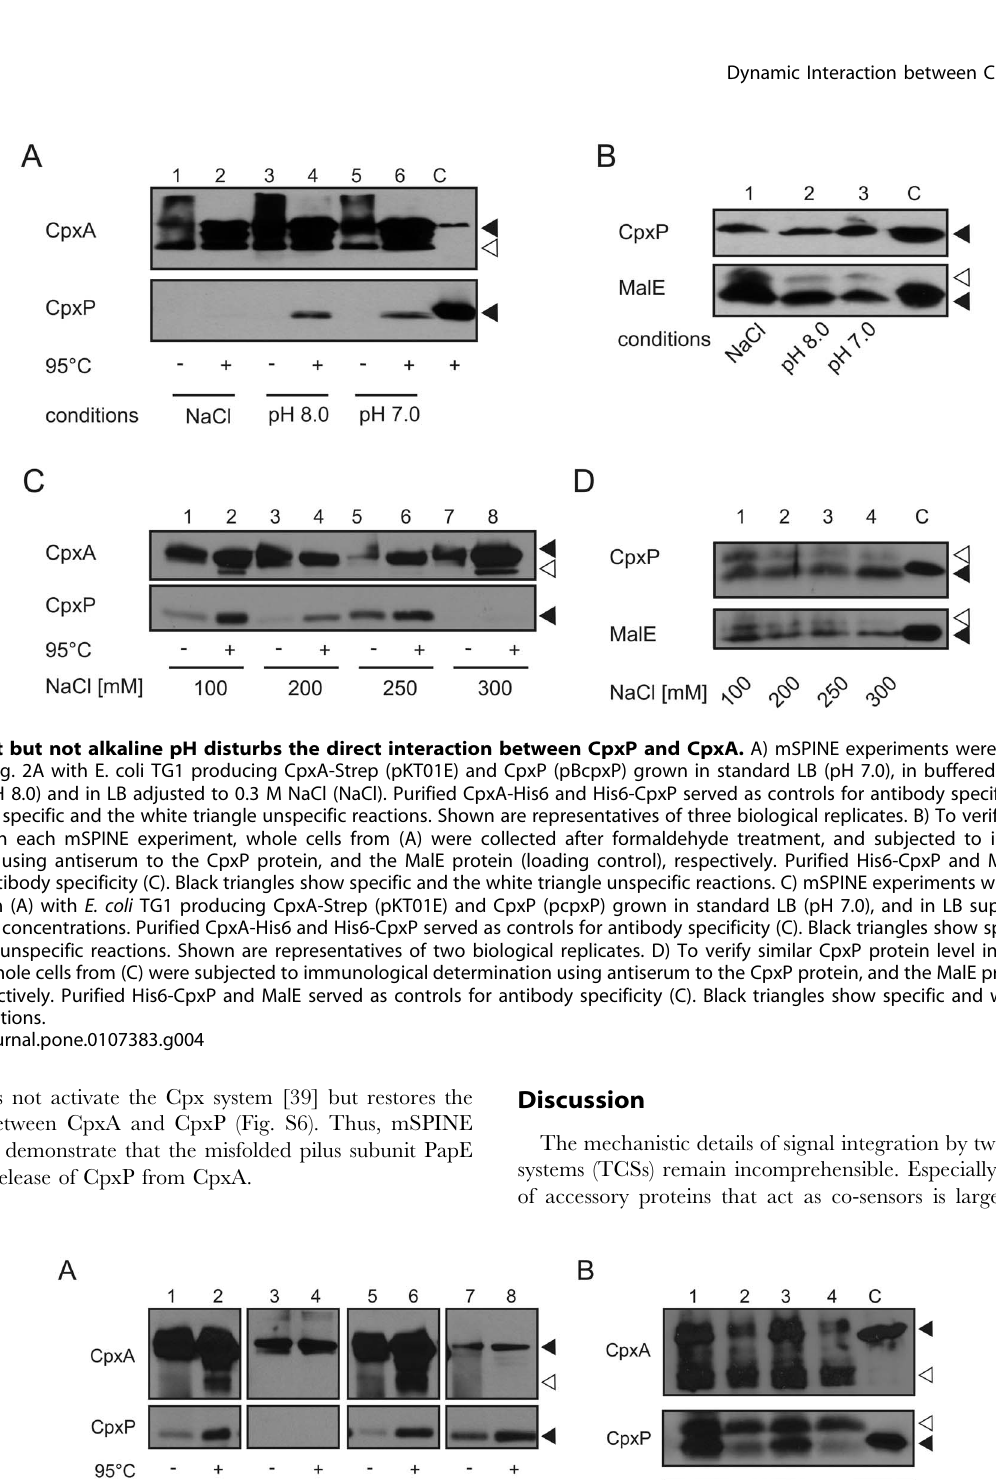
Figure 5. PapE induces the release of CpxP from CpxA. A) mSPINE experiments were performed as described in Fig. 2A with E. coli TG1 producing CpxA-Strep and either CpxP (WT) or the cleft mutant CpxPA108V (A108V) without or with PapE co-expression. Due to reduced CpxA-Strep level, mSPINE samples co-expressing PapE were five-fold stronger concentrated than samples without PapE. To allow comparison, immunoblots were cut into an upper and lower part. The upper part was probed with antiserum against CpxA and the lower part with antiserum against CpxP. Immunodetection was carried out for both parts simultaneously. Black triangles show specific and the white triangle unspecific reactions. Shown are representatives of three biological replicates. B) To visualize protein level in each mSPINE experiment, whole cells from (A) were collected after formaldehyde treatment, subjected to immunological determination using antiserum to CpxA, CpxP, and MalE (loading control). Purified CpxA-His6, His6-CpxP and MalE served as controls for antibody specificity (C). Black triangles show specific and white triangles unspecific reactions.